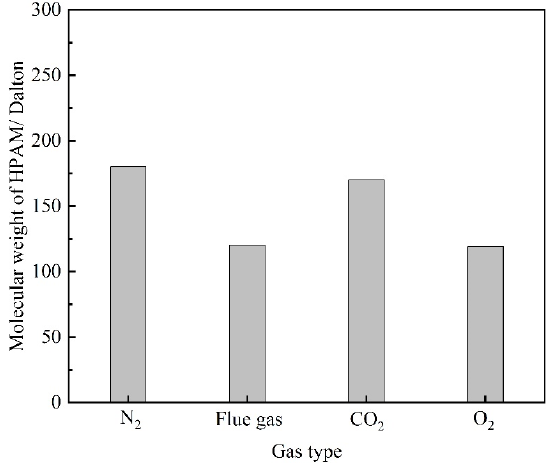
Figure 12. The changes in the molecular weight of HPAM treatment with different gas.